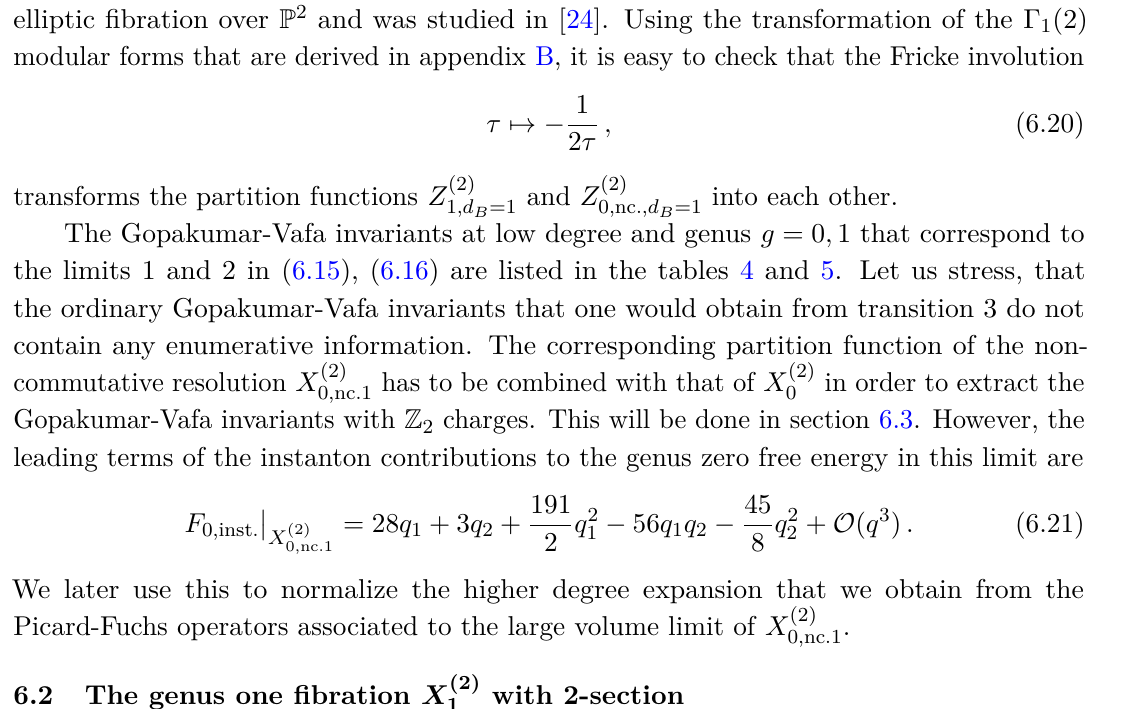
with q 1 = exp(2 πit 1 ) in the − 1 2 → q 1